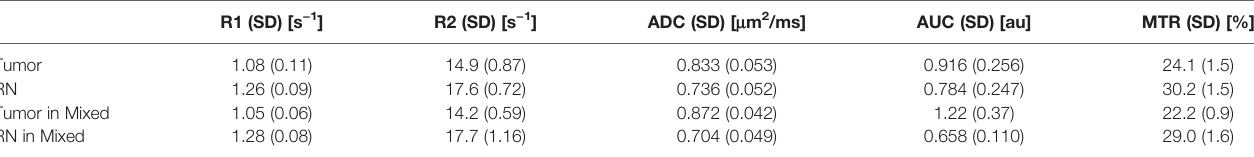
TABLE 1 | Mean MR Parameter